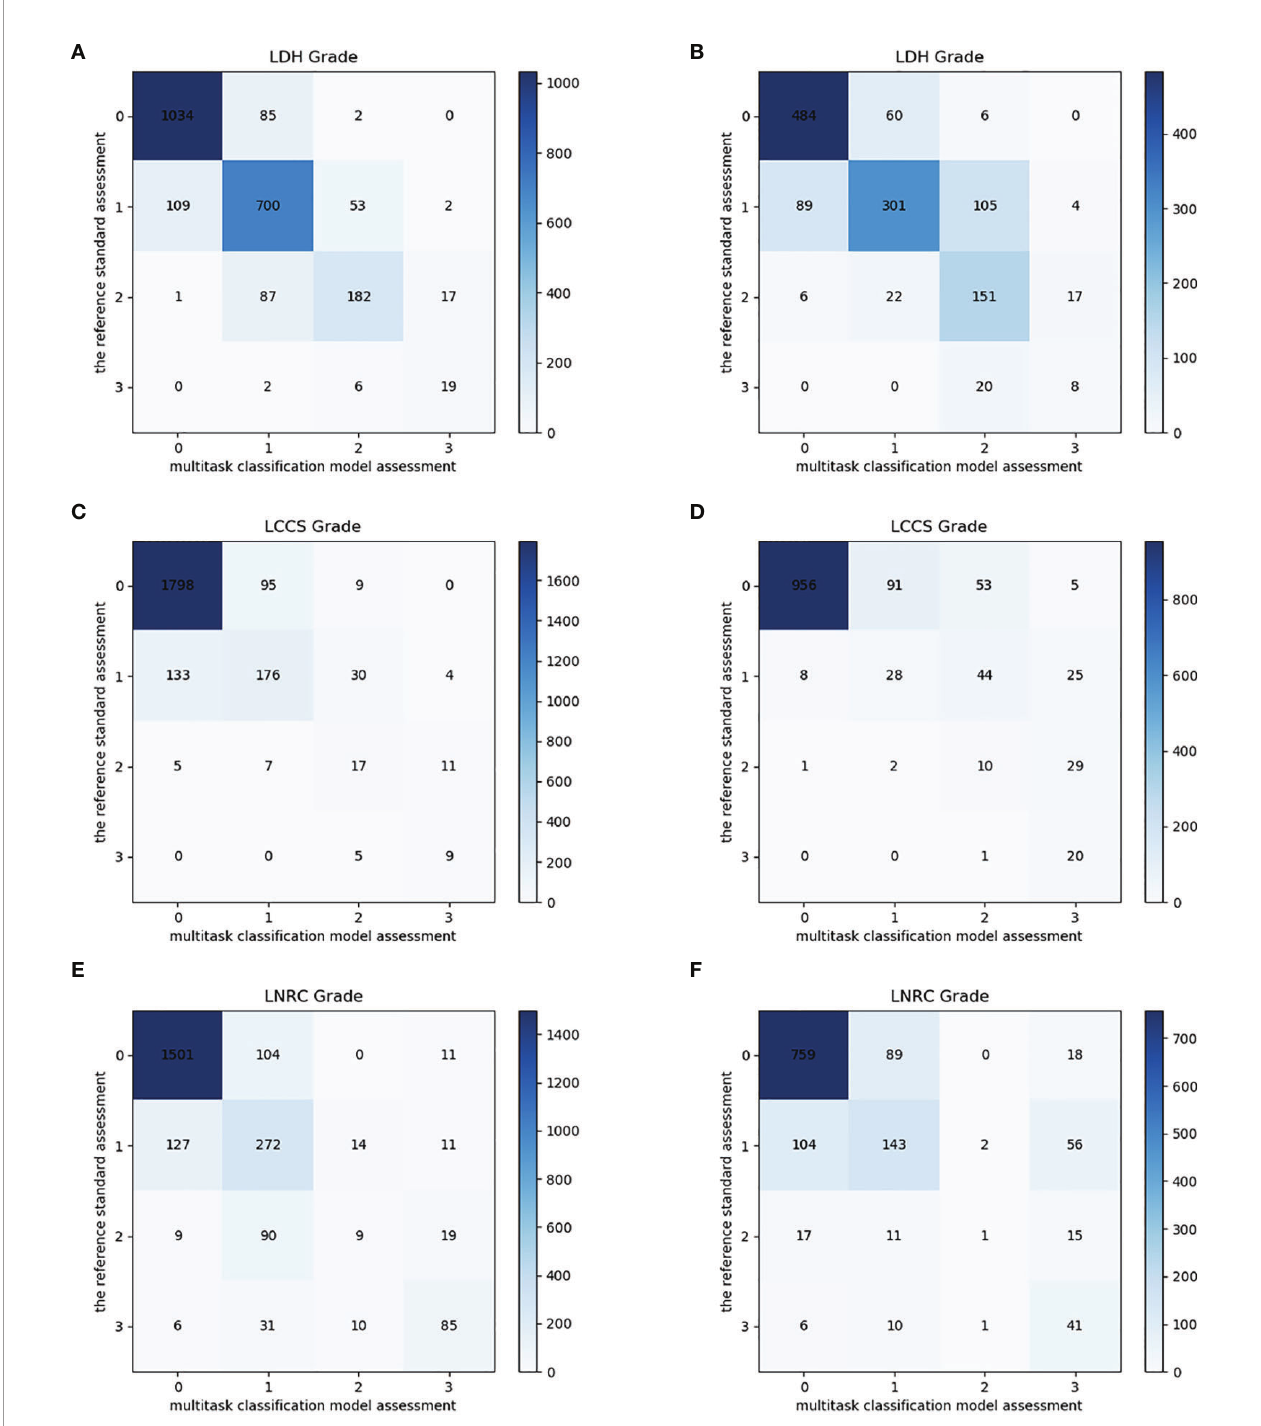
FIGURE 6 | Confusion matrix of the multi-task classi fi cation model at axial MRIs. Confusion matrix of the multi-task classi fi cation model for grading lumbar disc herniation LDH (A) , lumbar central canal stenosis LCCS (C) and lumbar nerve roots compression LNRC (E) on the internal test dataset. Confusion matrix of the multi-task classi fi cation model for grading LDH (B) , LCCS (D) and LNRC (F) on the external test